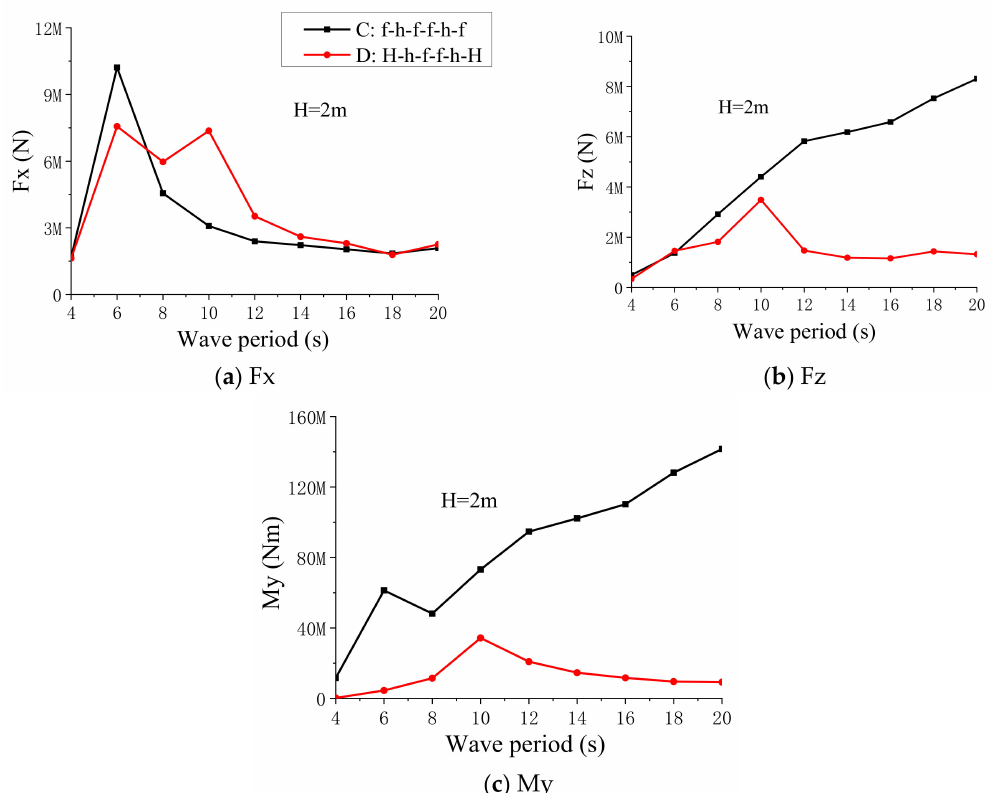
Figure 9. Main loads of the C1 with two suggested connection modes under different wave periods: ( a ) Fx, ( b ) Fz, ( c ) My.